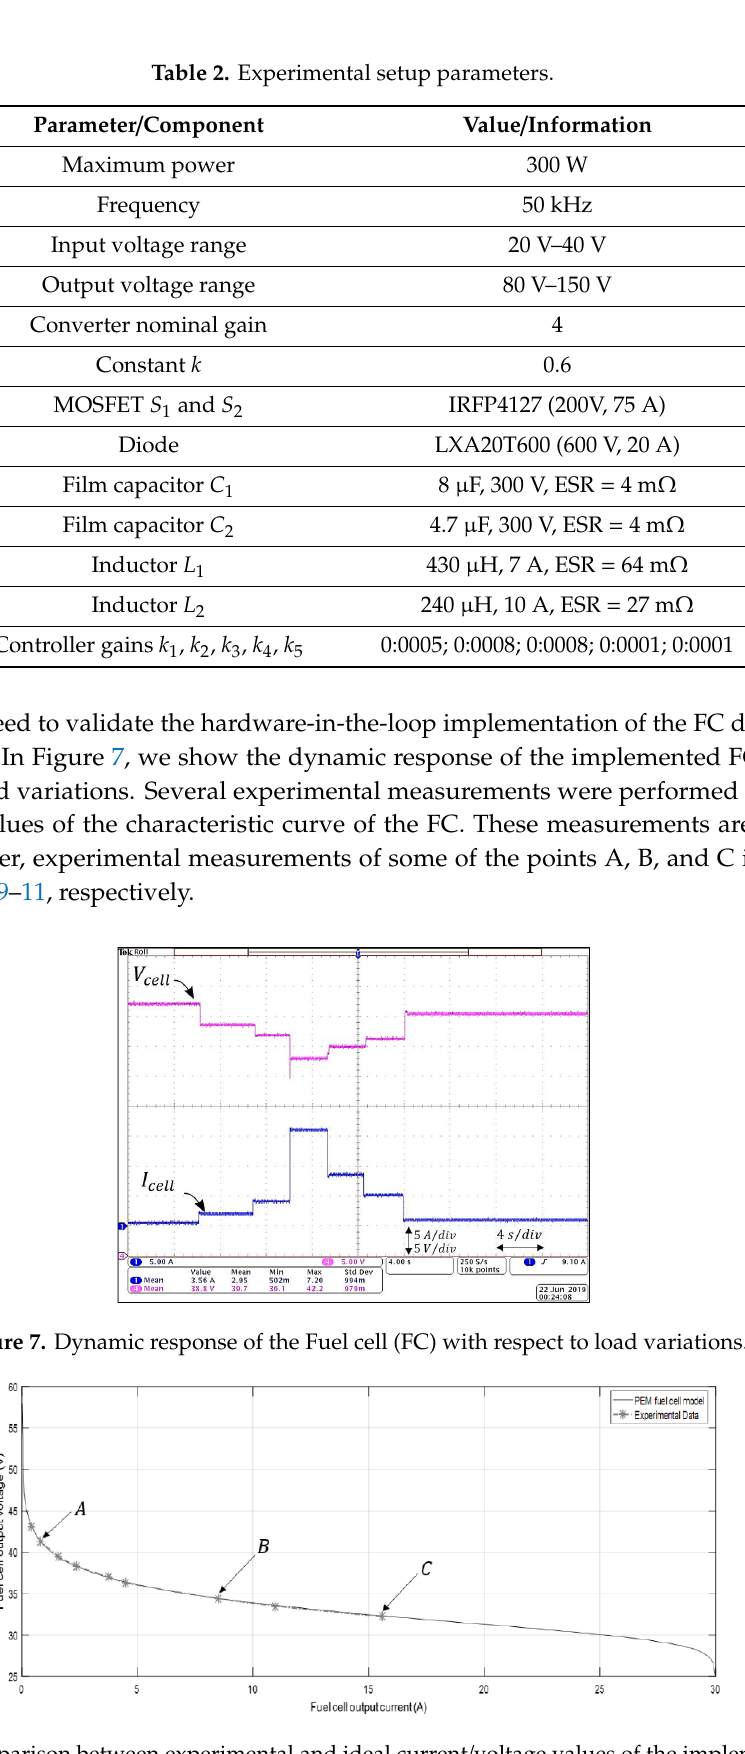
Table 2. Experimental setup parameters.